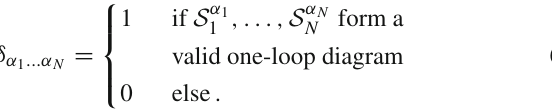
that have the same external legs E i and loop propagators but different external subtrees w